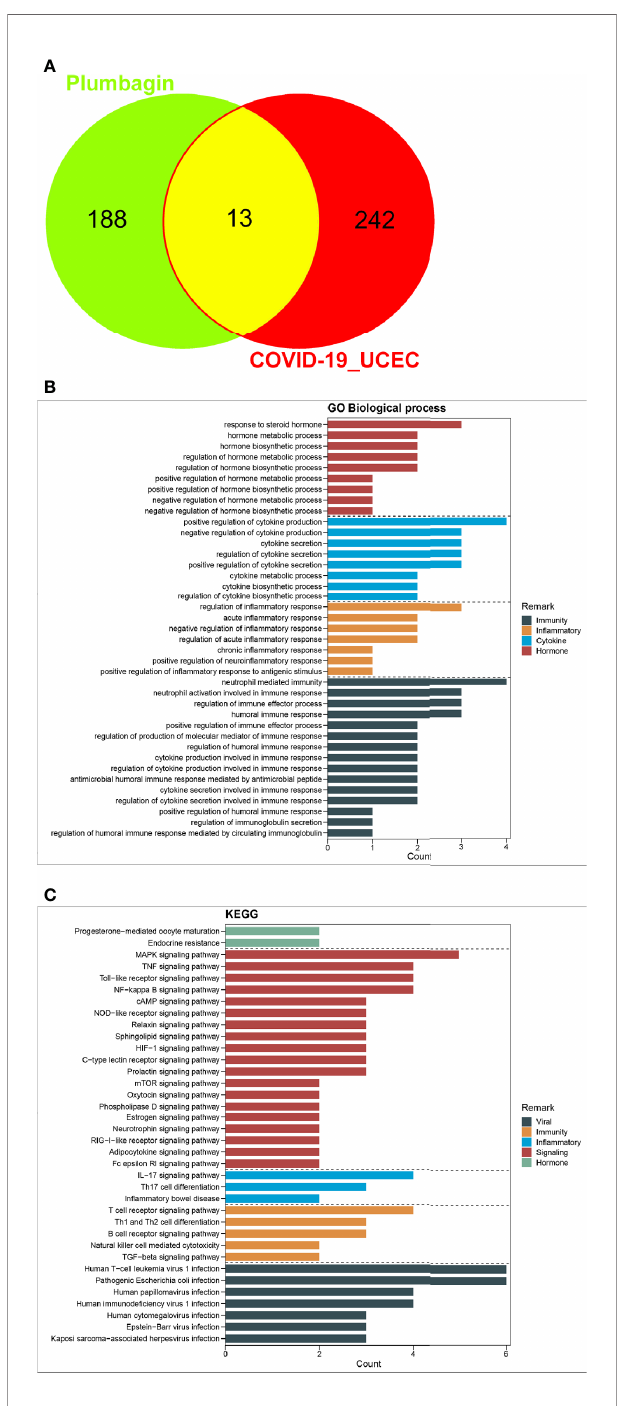
FIGURE 4 | Preliminary fi ndings of network pharmacology. (A) , The candidate, mutual genes of PLB and UCEC/COVID-19 in a Venn diagram. (B, C) , GO-based biologic process and KEGG-based signaling pathway of PLB against UCEC/COVID-19 following enrichment